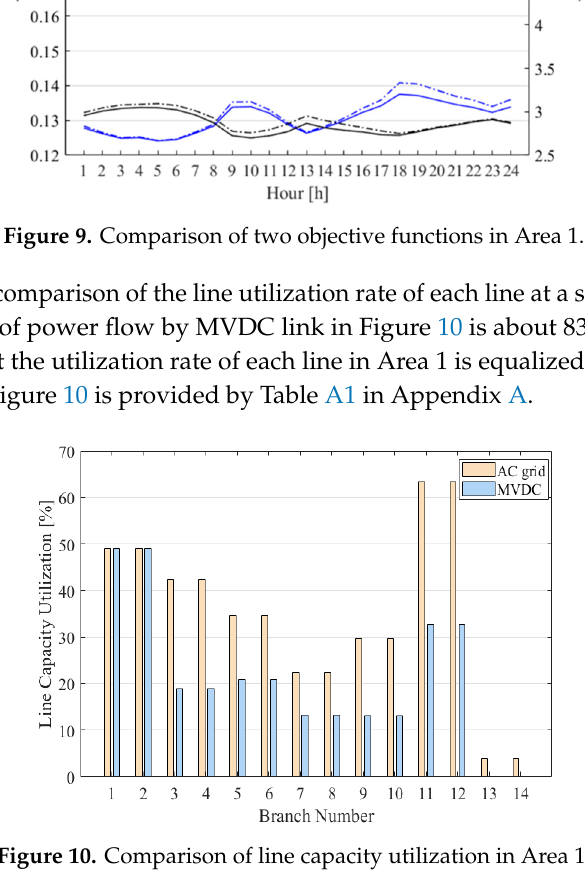
Figure 10. Comparison of line capacity utilization in Area 1.